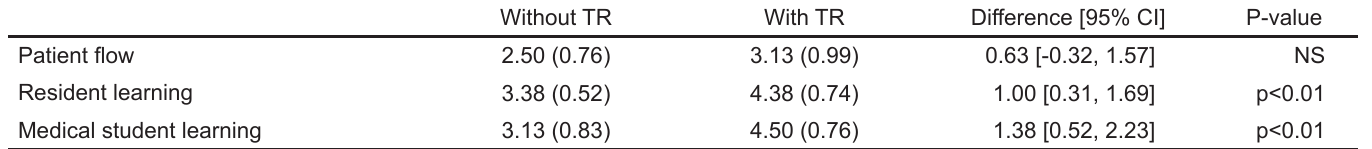
Table 4. Emergency medicine attending physician evaluation of emergency department experiences with and without the presence of the teaching resident (TR). Five-point scale responses were converted to ordinal numbers where 1=“Poor” and 5=“Excellent”. Values are reported as mean (SD). P-values were determined by a two-tailed, unpaired Student’s t-test. The response rate was 8/12